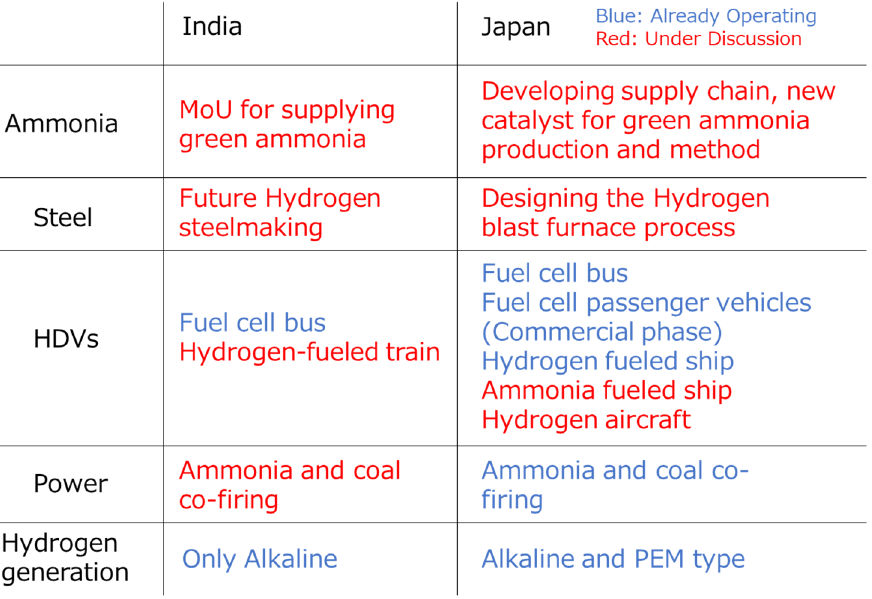
Figure 4. Progress of projects in areas of particular interest to India.